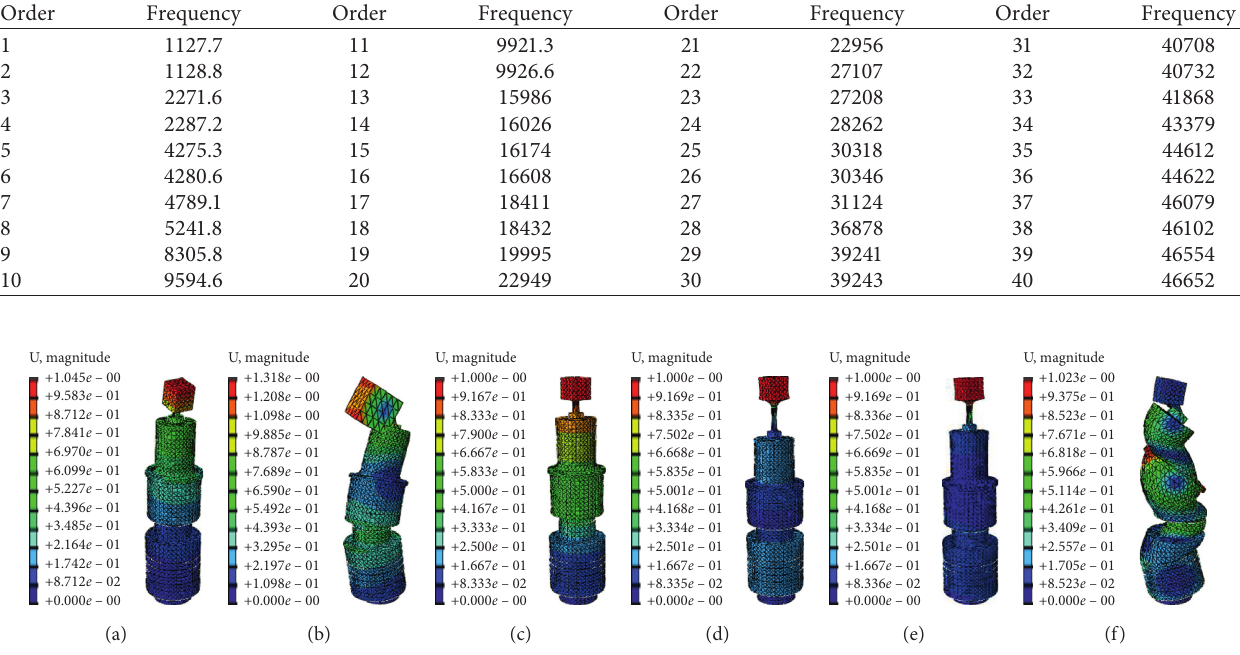
Table 2: Natural frequency of vibration device model.